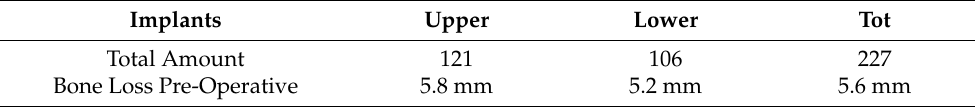
Table 2. Bone loss pre-operative (t 0 ).